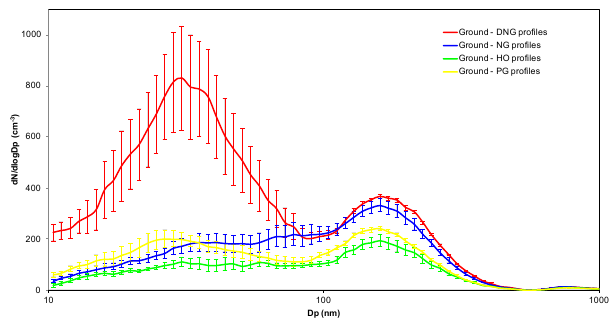
Figure 6. Springtime aerosol number size distribution measured at ground and timely coincident with homogeneous profiles (HO), positive gradient profiles (PG), negative gradient profiles (NG) and decoupled negative gradient profiles